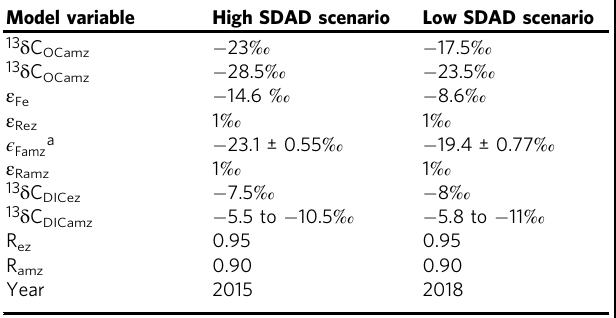
HCO 3 :CO 2 utilization is the ratio of HCO 3 utilization to CO 2 utilization in carbon fi xation ez euphoticzone, AMZ anoxicmarinezone, OC organiccarbon, DIC dissolvedinorganiccarbon, ε fractionation factor (F-carbon fi xation, R-respiration), SDAD sulfur-driven autotrophic denitri fi cation, 13 δ C isotopic composition of carbon pool a ε Famz is based on a weighted average of fractionation factors dependent on the relative carbon fi xation rates of each autotrophic metabolism present in the